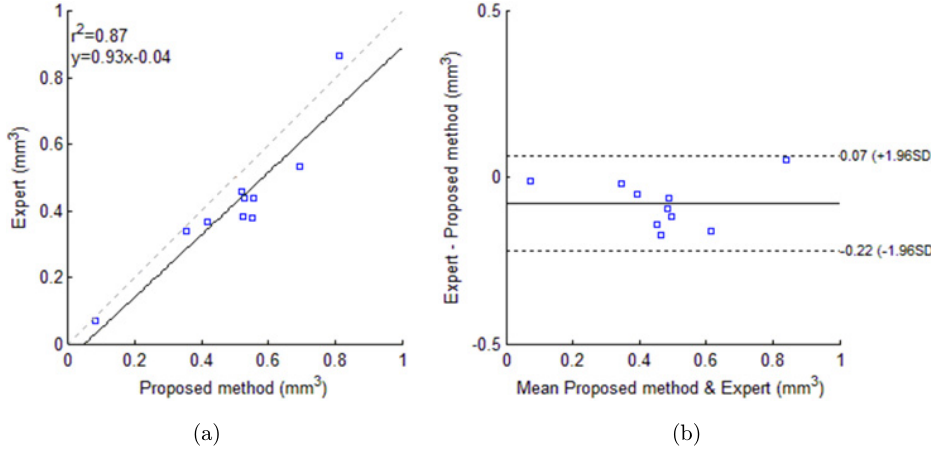
Fig. 11. (a) is the linear regression analysis comparing °uid volumes between the proposed algorithm and the expert and (b) is the Bland-Altman plot of the °uid volume between the proposed algorithm and the